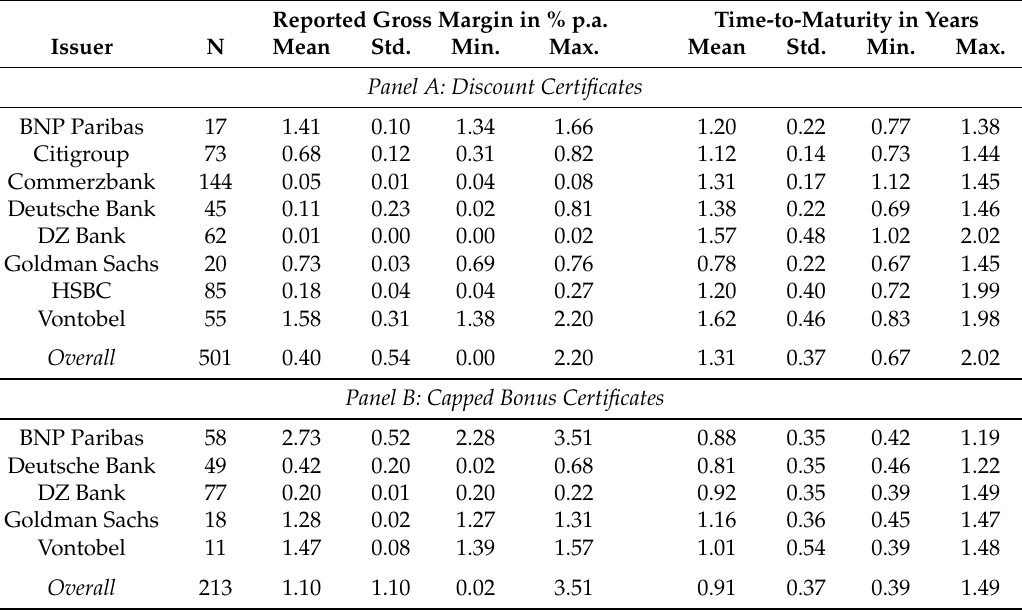
Table 1. Reported Gross Margins and Product